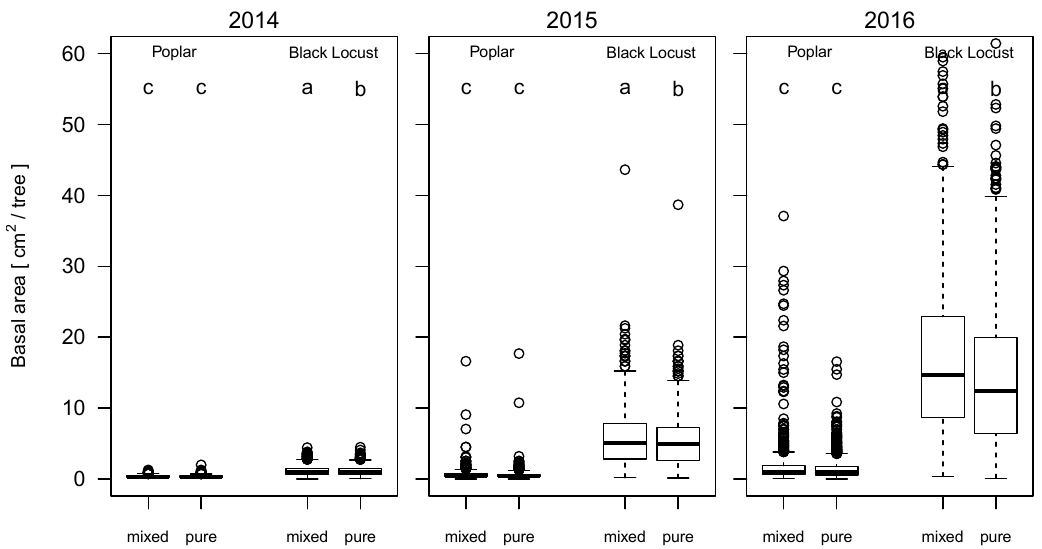
Figure 7. Basal area of poplar and black locust for the three years of the study in mixed and pure stands. Solid lines in the boxes represent the median and the bottom and the top of the box represent the first and third quartile (IQR). Each whisker represents 1.5 IQR. Different letters (a, b, and c) indicate significant differences between species and stand types, p < 0.05.